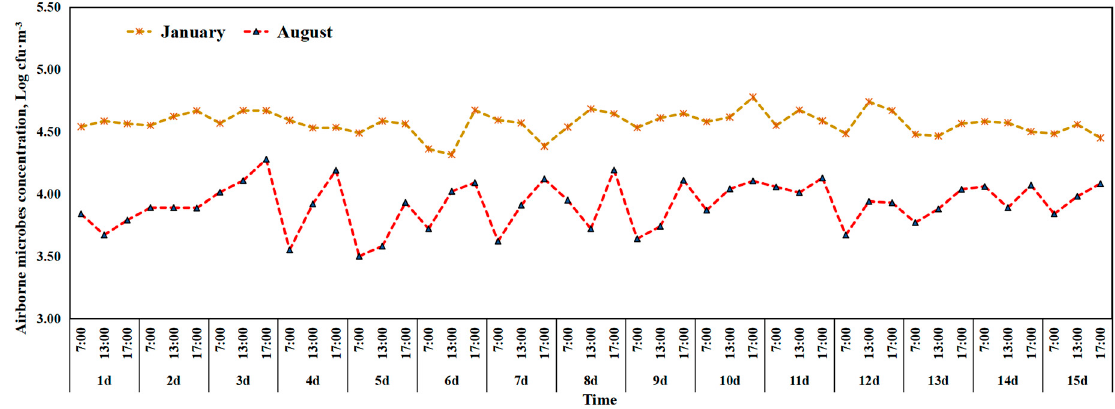
Figure 6. Variations in the number of airborne microbes among different sampling times during winter and summer.